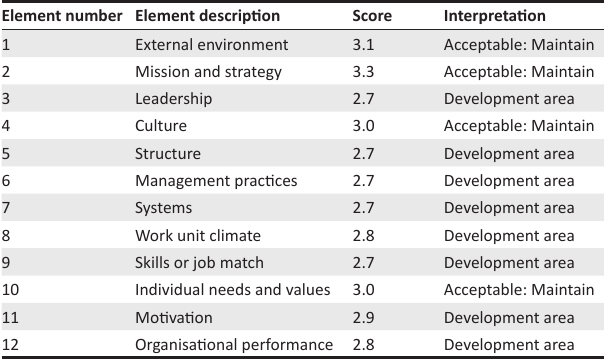
TABLE 3: Interpretation of Organisation Performance Questionnaire scores per element ( n =